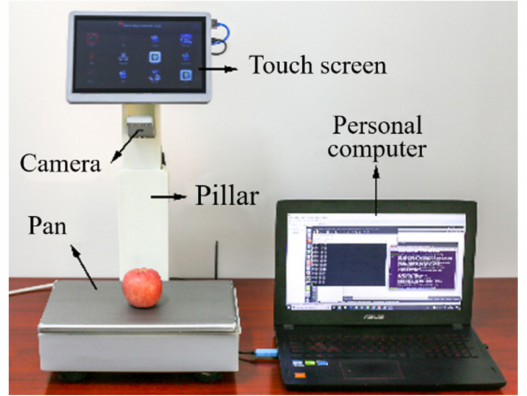
Figure 10. The entire mechanical structure of the ISSVS